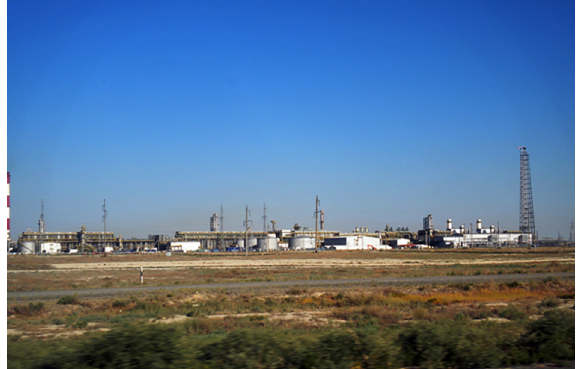
Fig. 3. Tengiz oil field. Gas processing plant-2. Source: photo taken by the